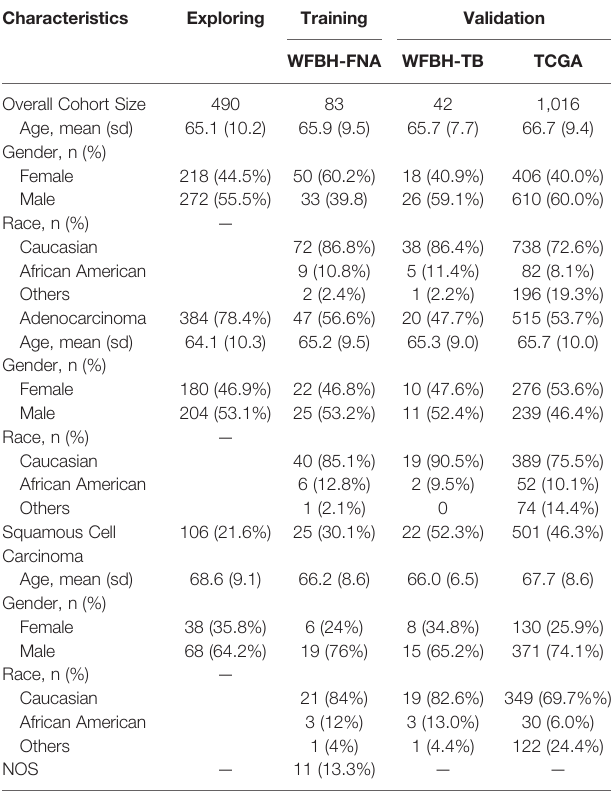
TABLE 1 | Patients ’